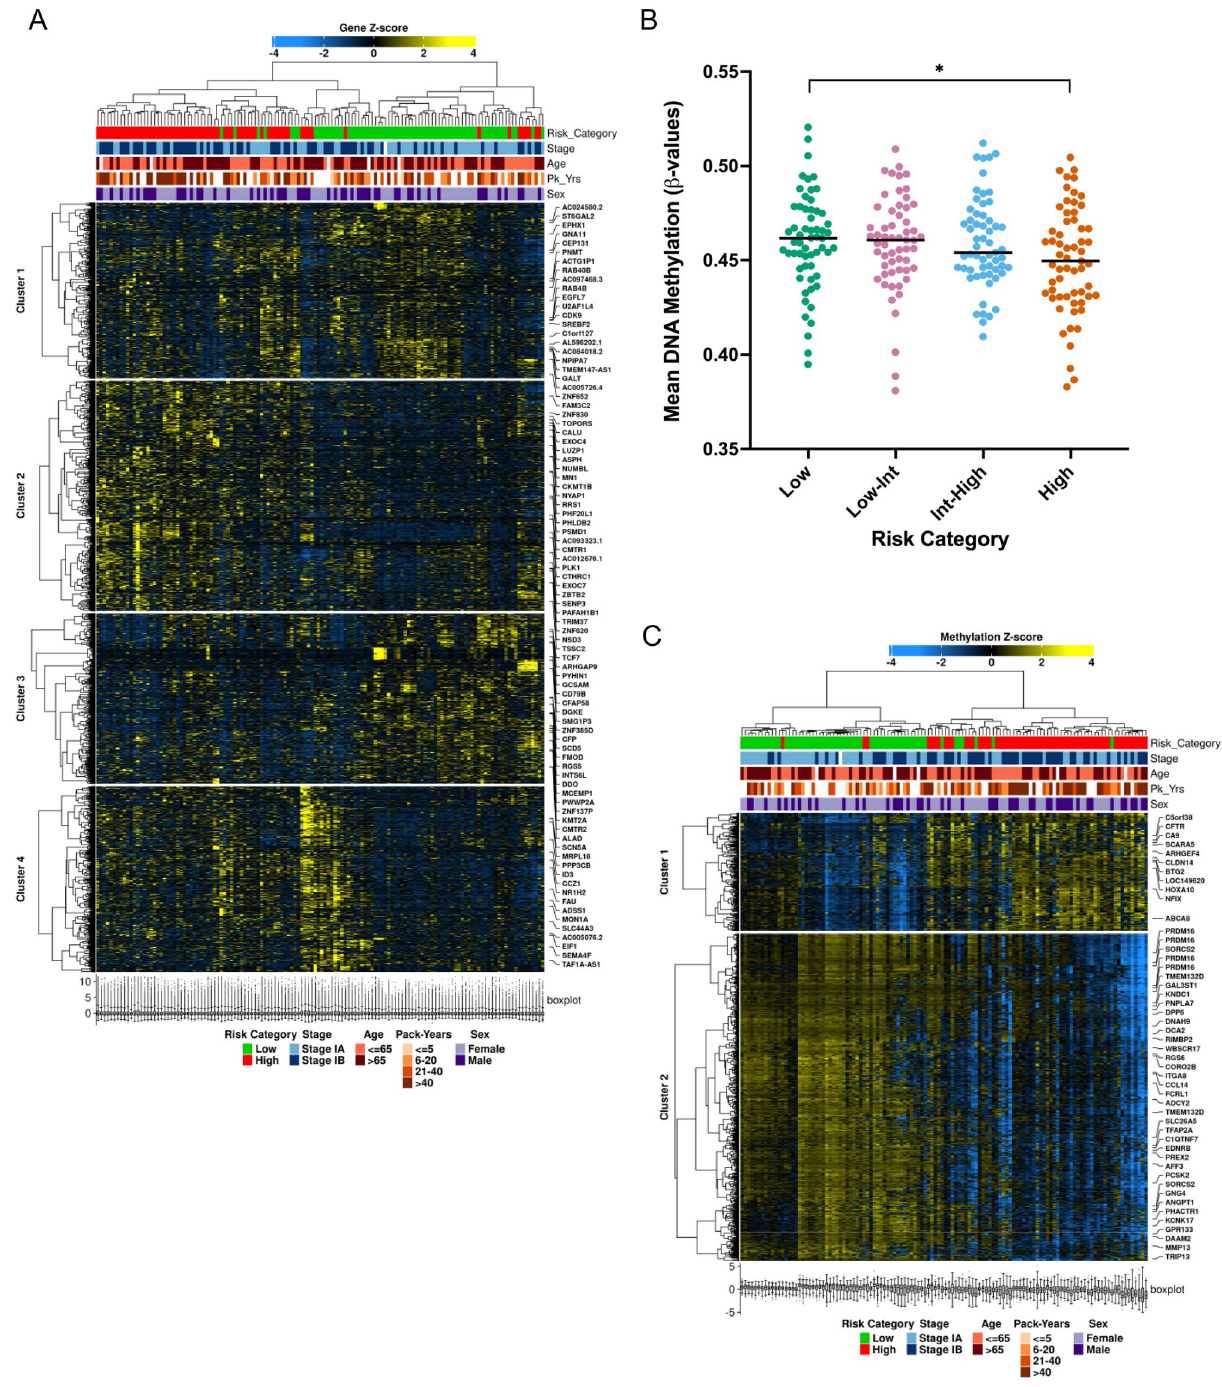
Figure 3. Transcriptomic analysis demonstrates distinct genomic and immunologic features of recurrent lung adenocarcinomas. Heatmap clustering of differentially regulated genes results in clear separation between high- and low-risk tumors across four different gene clusters ( A ). Differential methylation patterns are also associated with recurrent tumors; decreasing DNA methylation is observed in tumors with increasing risk of recurrence ( B ) while heatmap clustering of differentially methylated genes results in clear separation between high- and low-risk tumors across two different gene clusters ( C ). * P <